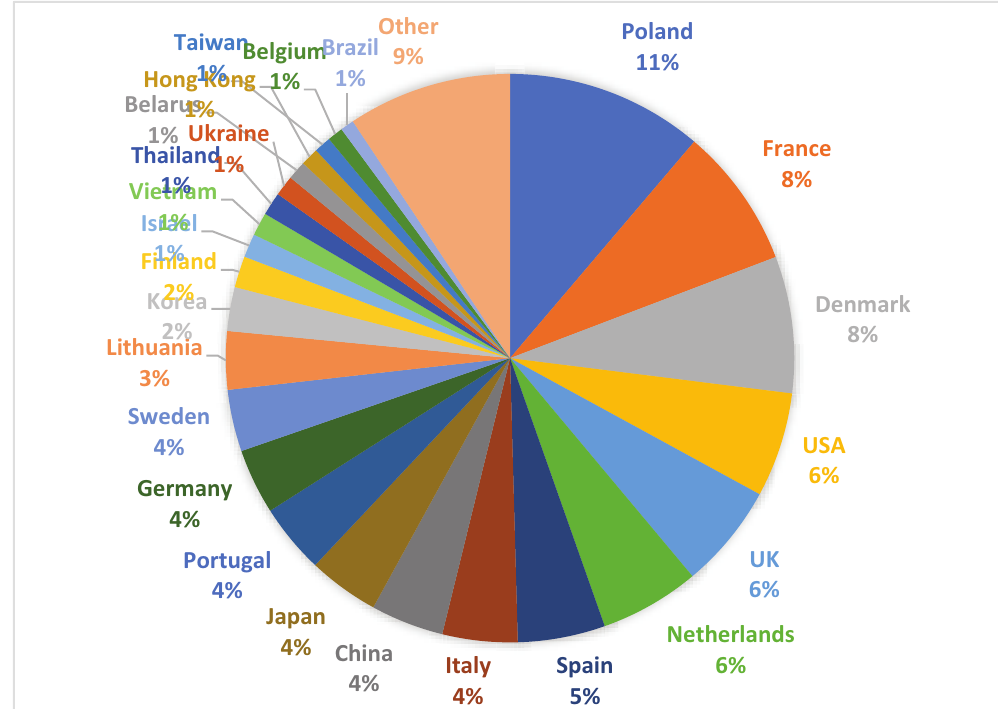
Fig. 4. Average market shares by destination country, 2016 –